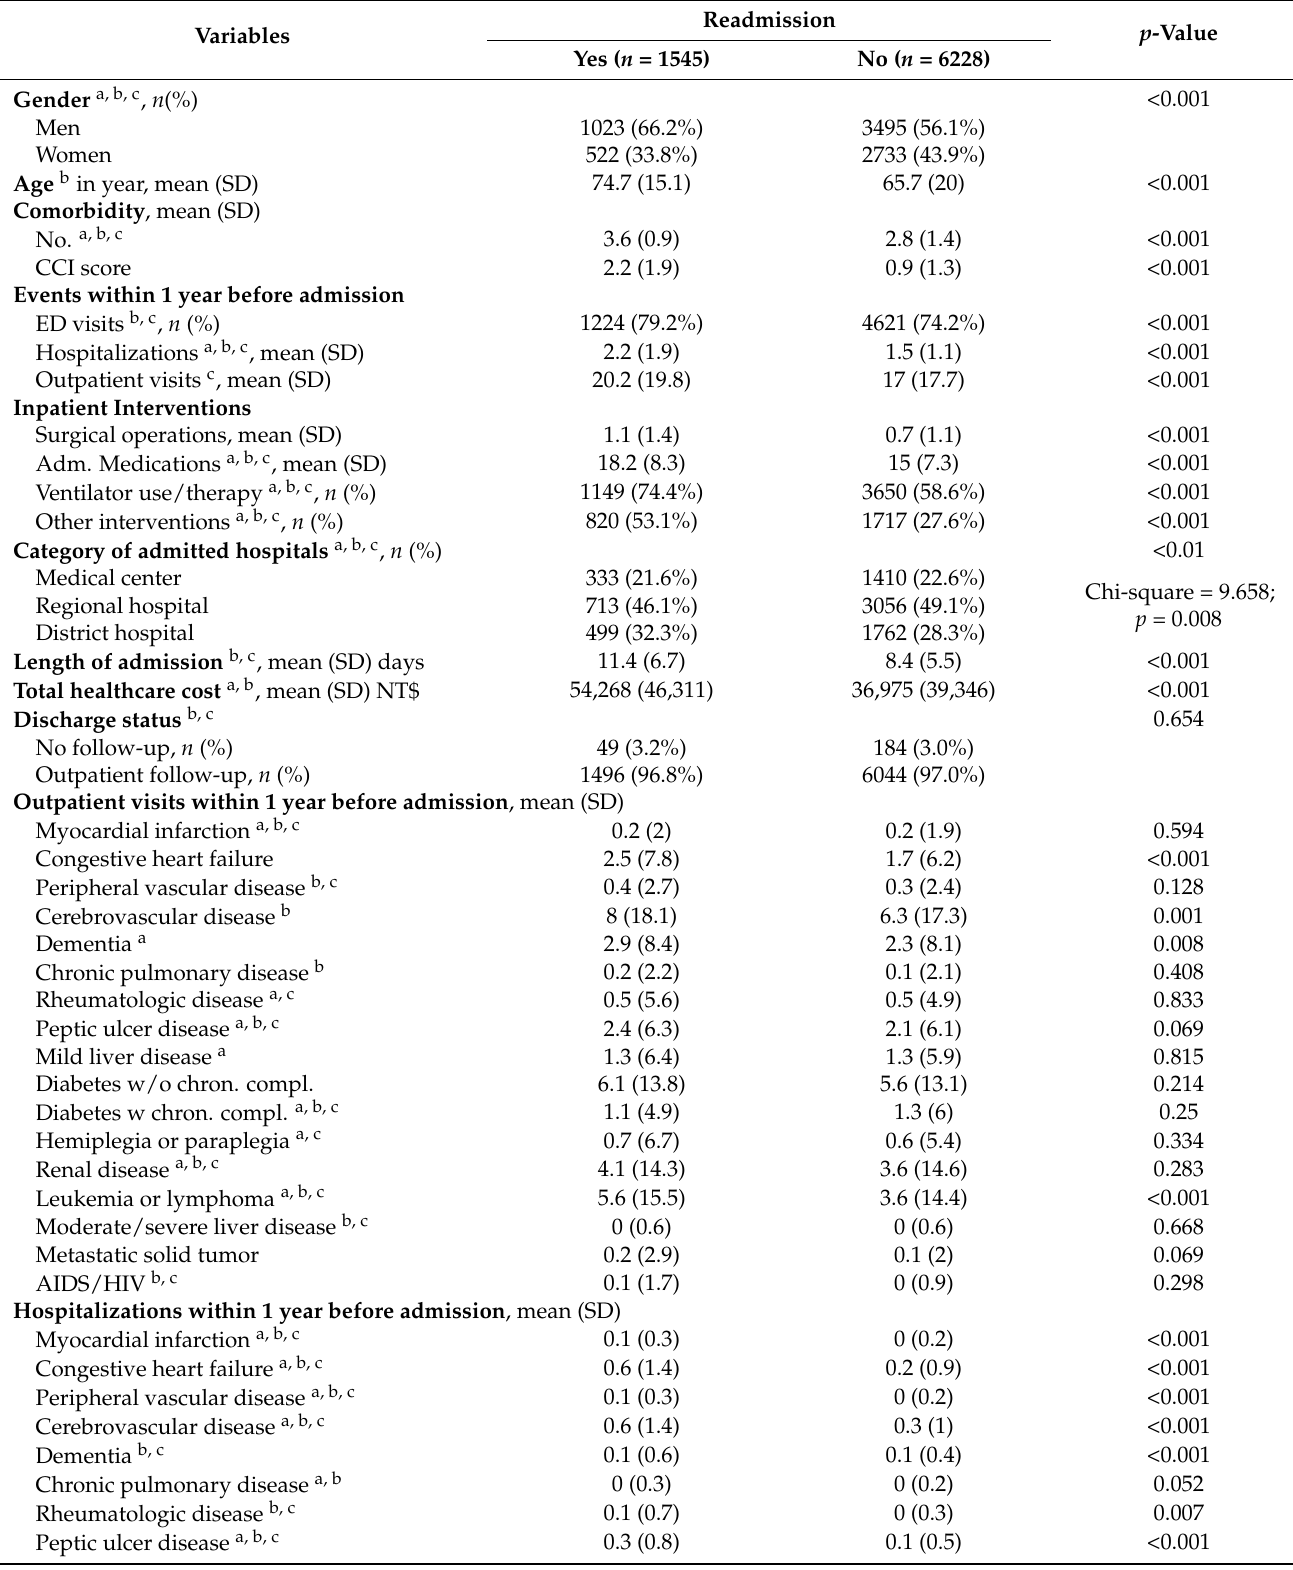
Table 4. Comparisons between pneumonia patients with and without